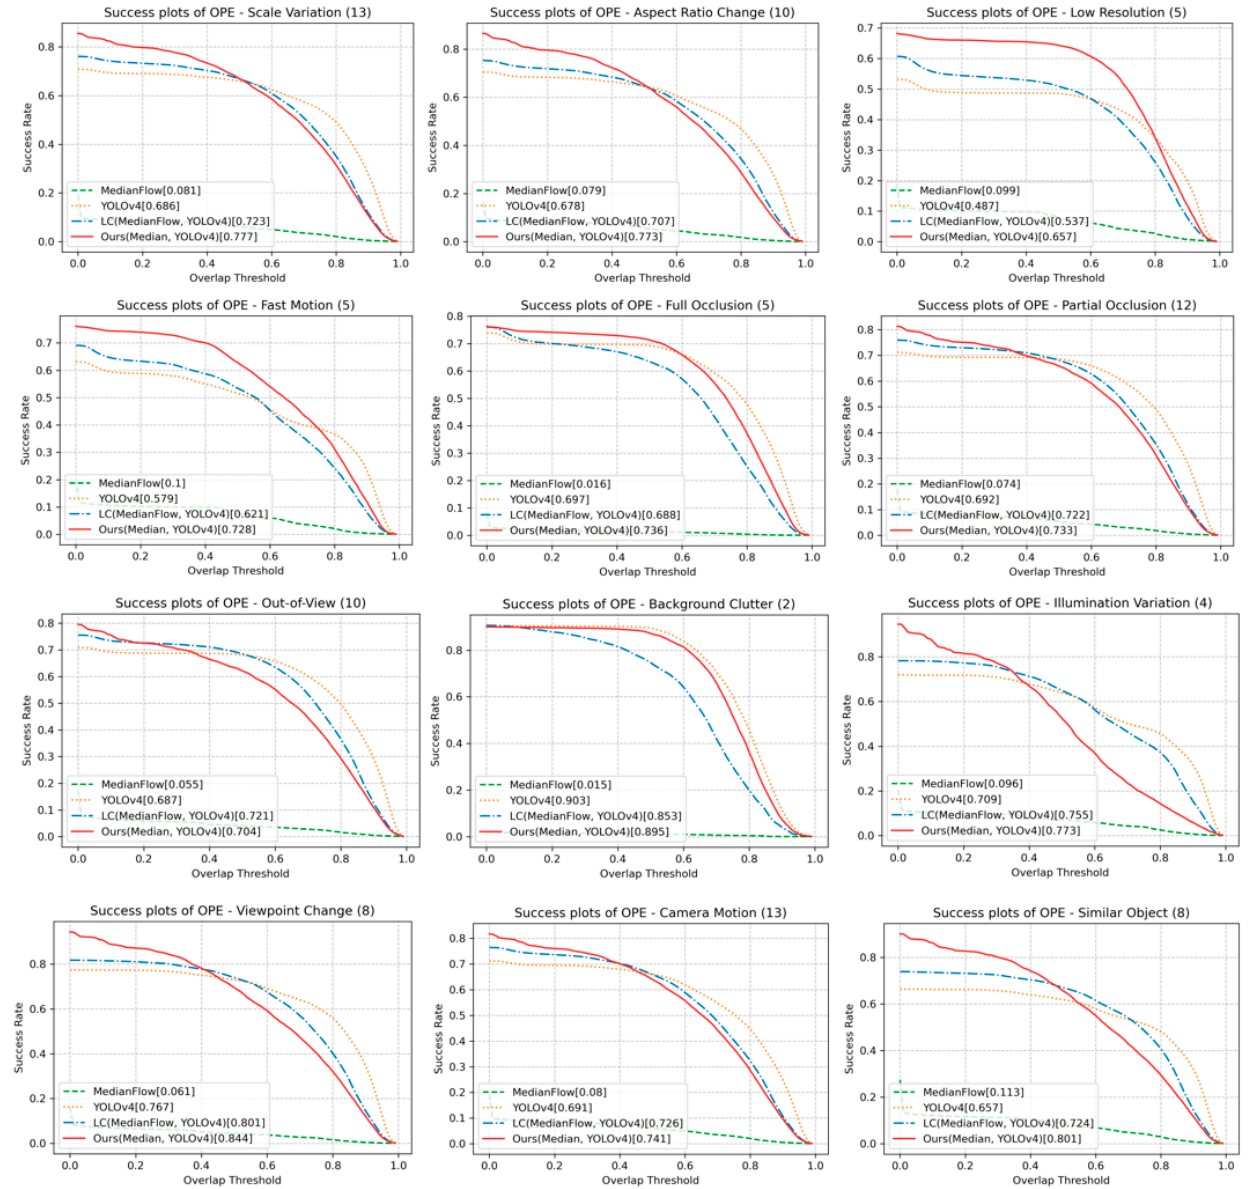
Figure 10. Success plots on di ff erent scenarios in UAVL dataset.